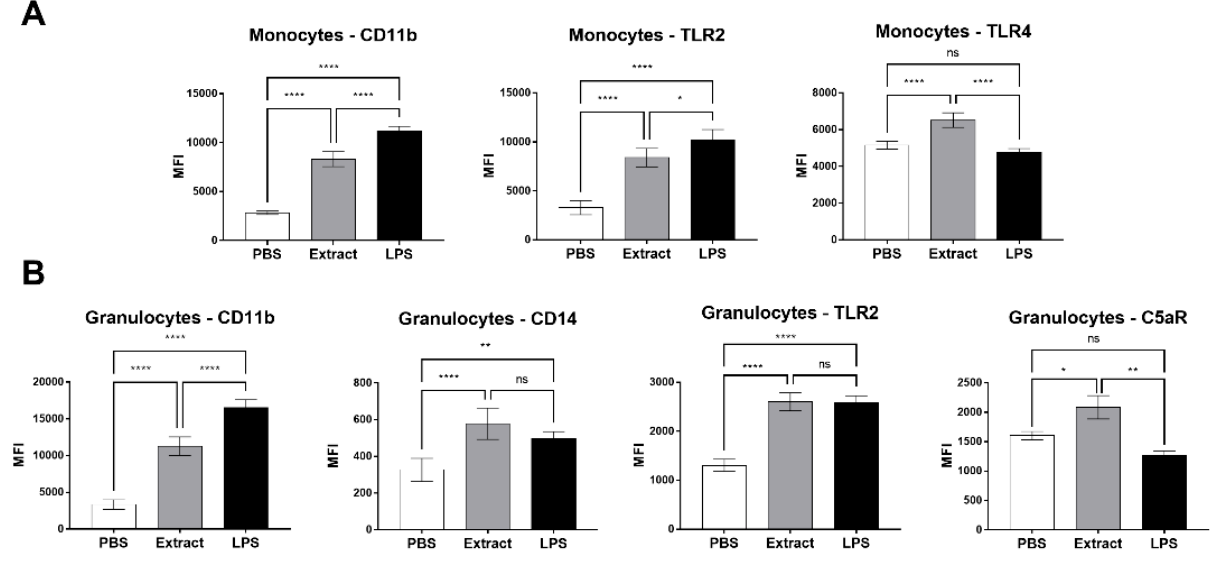
Figure 2. Expression of surface markers in monocytes and granulocytes stimulated with Pararama hair extract. Human blood samples anticoagulated with lepirudin (50 µg/mL) were incubated with Pararama hair extract (95 µg/mL), LPS (5 µg/mL), or PBS for 30 min at 37 °C. After lysis of erythro- cytes, cells were stained with anti-CD33 (monocytes), anti-CD66b (granulocytes), anti-CD11b, anti- CD14, anti-TLR2, anti-TLR4 and anti-C5aR. The expression of these markers was evaluated by flow cytometry, and the results are expressed as the median fluorescence intensity (MFI) after the acqui- sition of 20,000 events. The results are presented as the mean ± SD of three independent experiments. ( A ): Monocytes. ( B ): Granulocytes. * p : < 0.05. ** p : < 0.01. **** p : < 0.0001. ns: not significant.